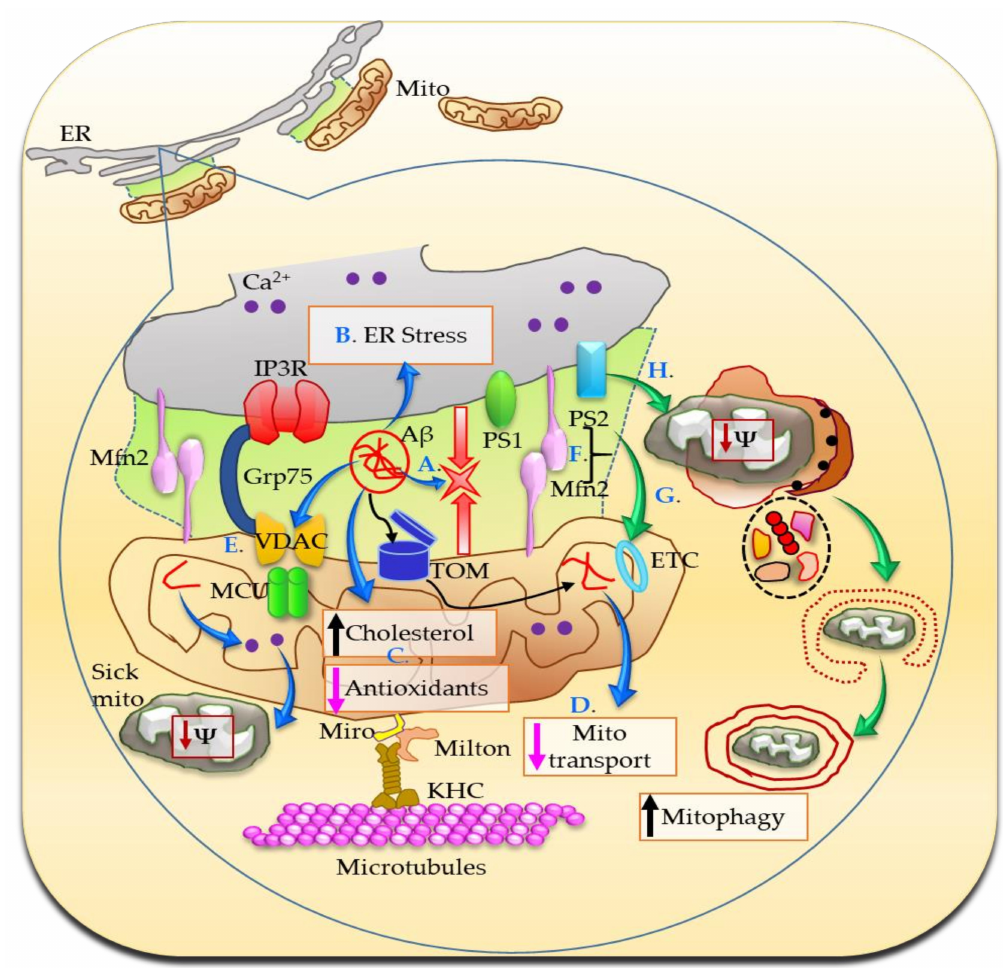
Figure 4. In AD, the MAMs are more abundant and are involved in A β production, which further increases ER–mitochondria juxtaposition (A). The translocase of the outer membrane (TOM) situated in the OMM serves as the A β transport machinery into the mitochondria. A β triggers ER stress (B) and promotes mitochondrial cholesterol accumulation and antioxidant depletion (C). Mutated PS1 and PS2 open IP3R channel flooding intracellular Ca 2+ and also stimulate A β production (not shown). A β mediated higher degree of apposition between ER and mitochondria produces exaggerated Ca 2+ signaling, which further results in abnormal mitochondrial transport (D). Moreover, A β , phosphorylated tau, and γ -secretase interact with VDAC resulting in a cascade of toxic effects, including mitochondrial dysfunction and eventually cell death, during the course of AD development and progression (E). Furthermore, PS2 and Mfn2 coordinate to increase ER–mitochondria coupling (F). The excessive Ca 2+ is toxic for cells especially under stress conditions and over long periods of time, modulates electron transport system (ETC) and increases mitophagy